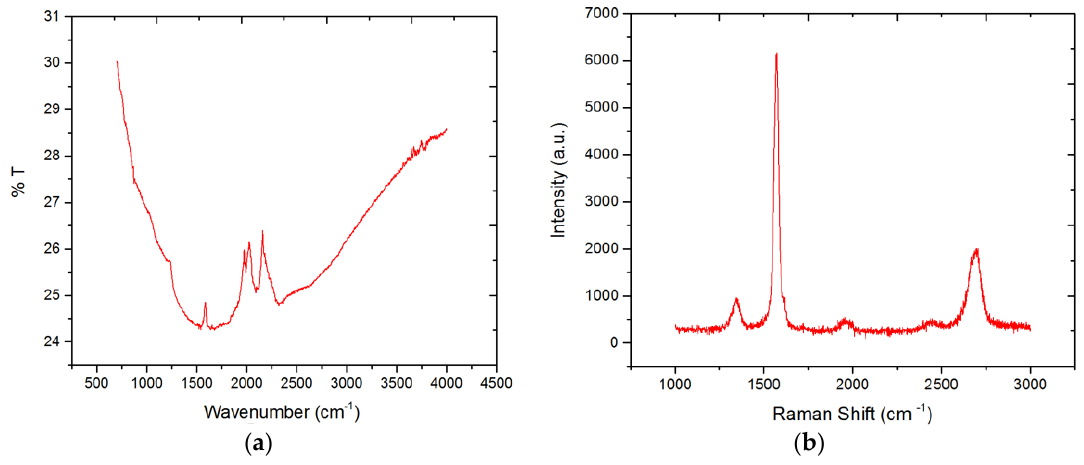
Figure 2. ( a ) Attenuated total reflectance-Fourier transform infrared (ATR-FTIR) spectroscopy (Frontier Perkin Elmer) equipped with single reflection ATR attachment. ( b ) Raman spectra of fabricated graphene nanosheets. The locations of the D peak, G peak and 2D peak are 1341.58 cm −1 , 1573.55 cm −1 and 2688.76 cm −1 , respectively. The obtained intensity ratio I D / I G of 0.32 represents manufacturing of high quality GNS.